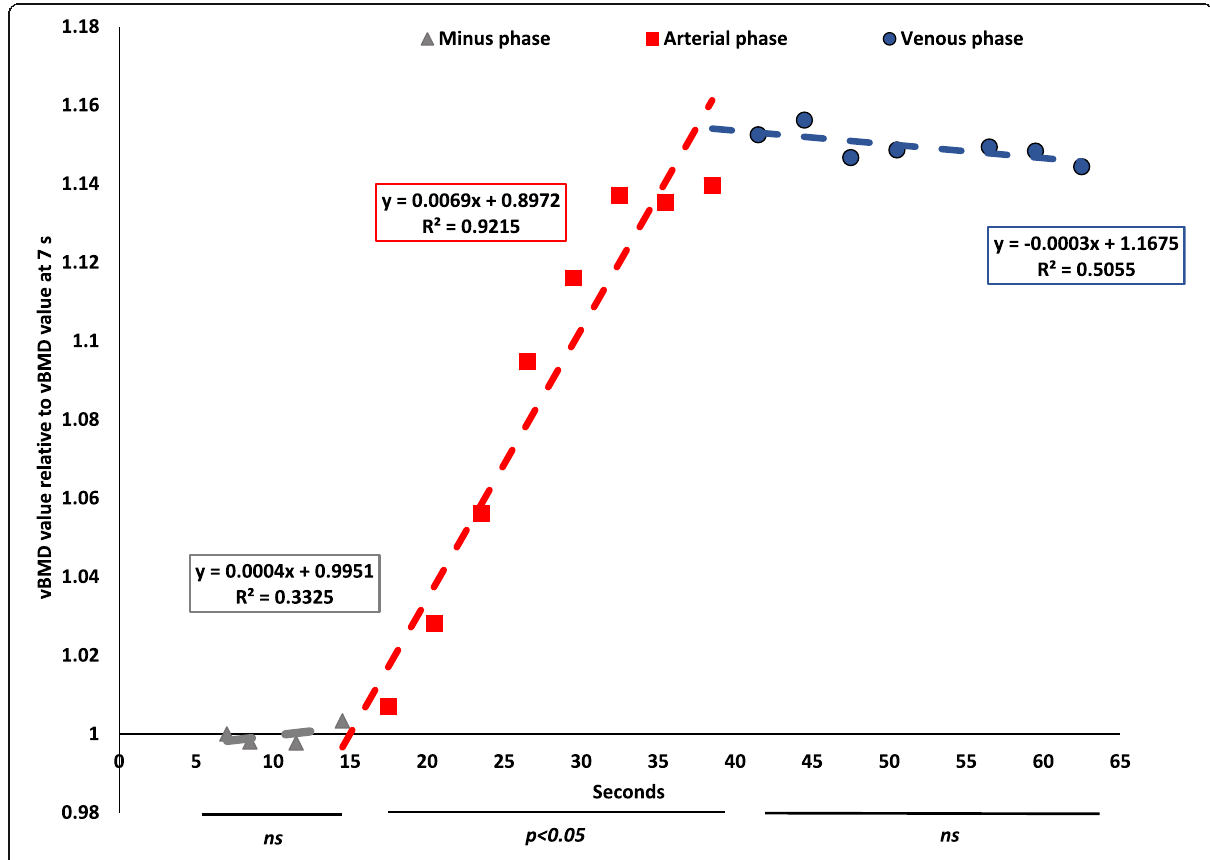
Fig. 5 Normalised mean data of the relative change in volume bone mineral density (vBMD) compared to the vBMD value at 7 s (unenhanced phase in vertebrae) in the computed tomography perfusion imaging examination. The curve was divided in three subareas (unenhanced phase, grey; arterial phase, red; and venous phase, blue). As it can be seen visually and by the accompanying mathematical formula, the unenhanced and venous phase shows a near horizontal line while the arterial phase shows a steep increase of vBMD change over time. There was a significant change in neighboring time points between 17.5 s to 41.5 s. After that time point, there was no detectable difference between the neighboring time